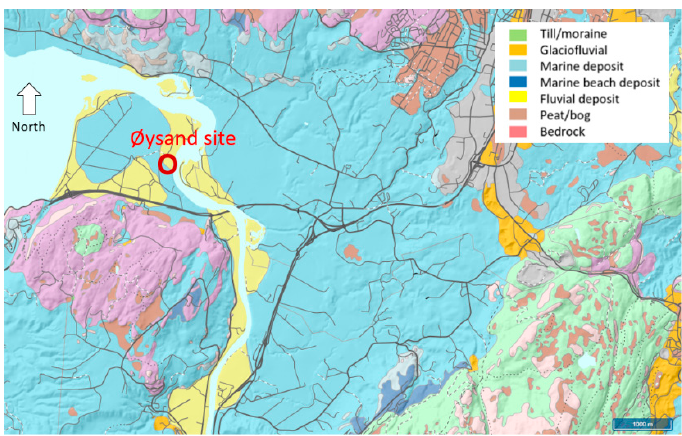
Figure 1. Location and geological map of Øysand research site (google.maps and www.ngu.no).